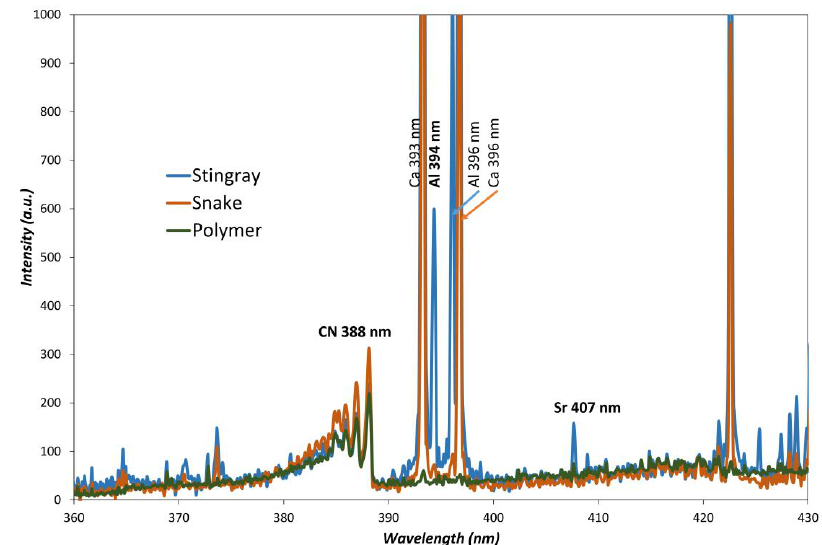
Figure 3. Molecular CN band from polymer (ABS) and different leathers (stingray and snake).